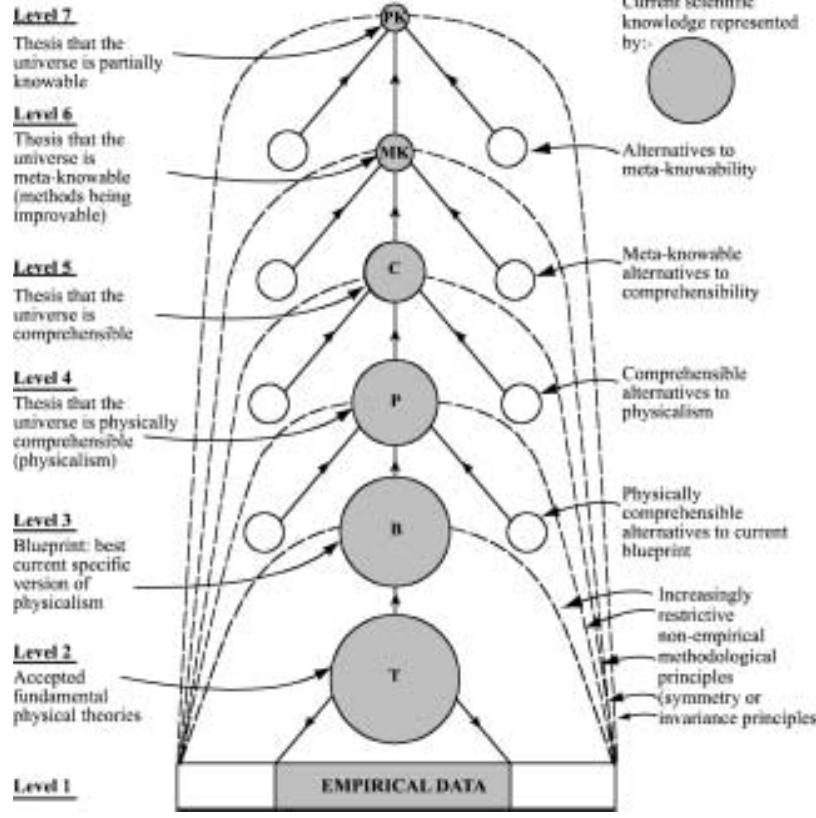
Figure 2. Hierarchical conception of